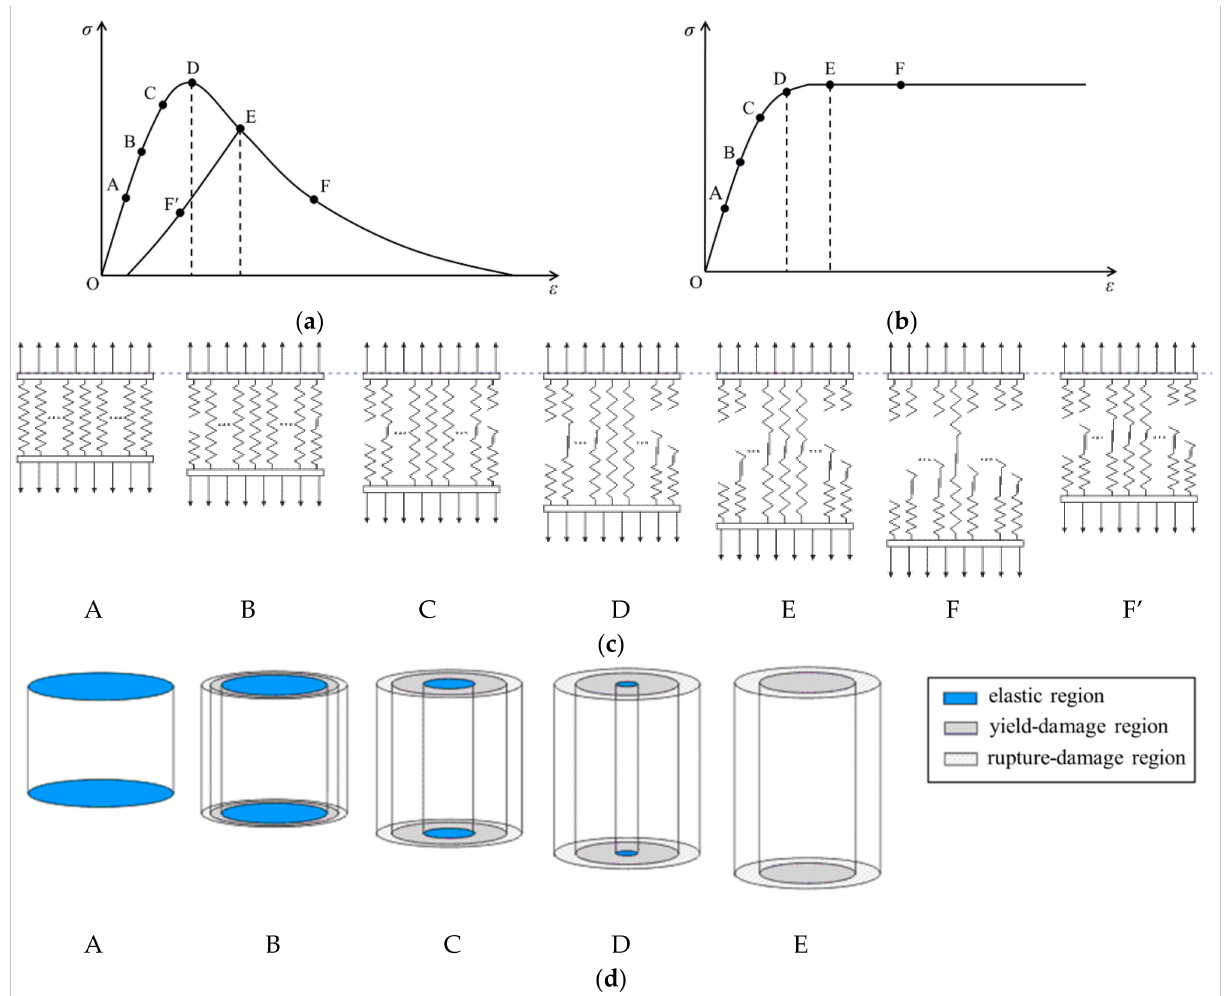
Figure 3. Uniaxial tensile damage evolution process: ( a ) nominal stress–strain curve; ( b ) effective stress–strain curve; ( c ) microscopic spring beam model; ( d ) cylinder